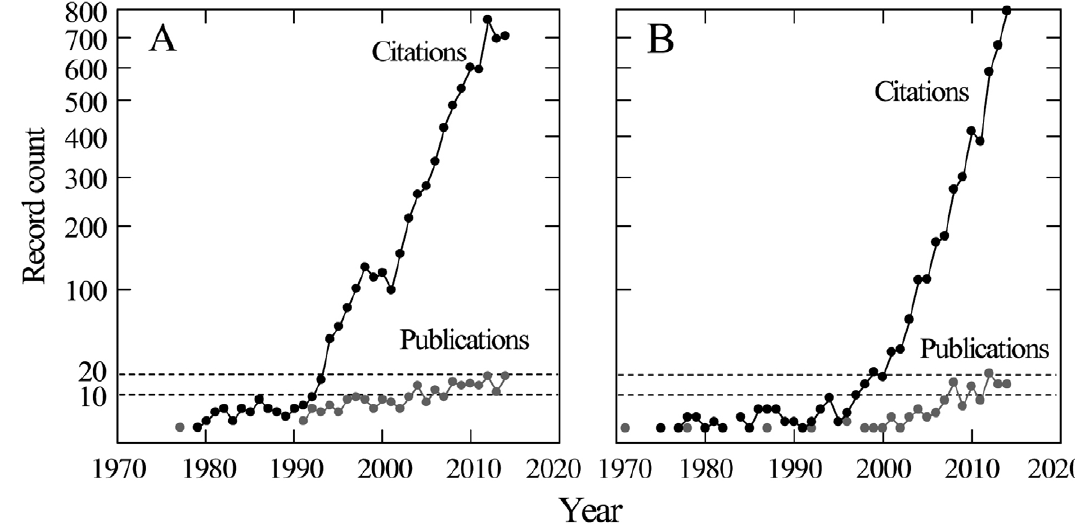
Fig. 1. – Evolution of the number of papers (in grey) and citations (in black) on sponge chemical (A) and microbial (B) ecology found in the Science Citation Index Expanded database from 1900 to 2014. Search terms: ( sponge OR porifera ) AND chemi* AND ecolog* and ( sponge OR porifera ) AND microb* AND ecolog* ,